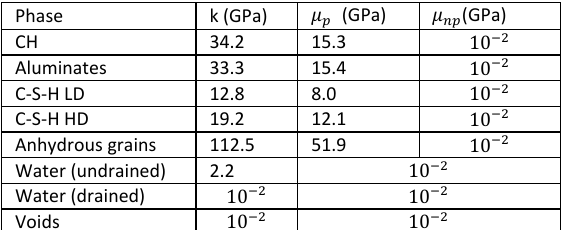
Table 1. Micromechanical properties of paste phases (issued from Young’s modulus and Poisson’s ratio given in [22, 23, 24] for percolated